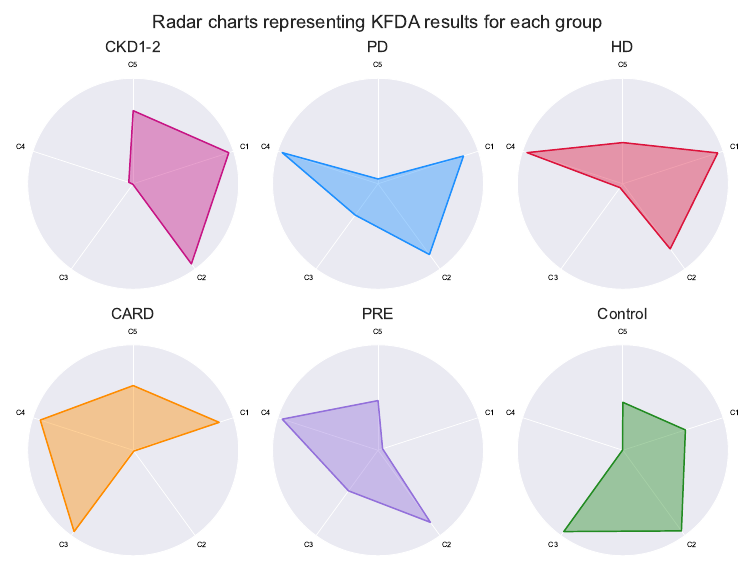
Figure 8. Radar charts for Kernel Fisher Discrimination Analysis results. Each chart represents distinct profiles of the analyzed groups drawn for the mean values of 5 components extracted during dimensionality reduction. The values for each individual component were standardized according to the scalar created for the whole patient population (n = 252) and normalized to fall between 0 and 1 values afterward. The lowest values are in the circle center, and the highest touch the circumference. The white lines are provided to easily track values calculated for each component according to the label outside the